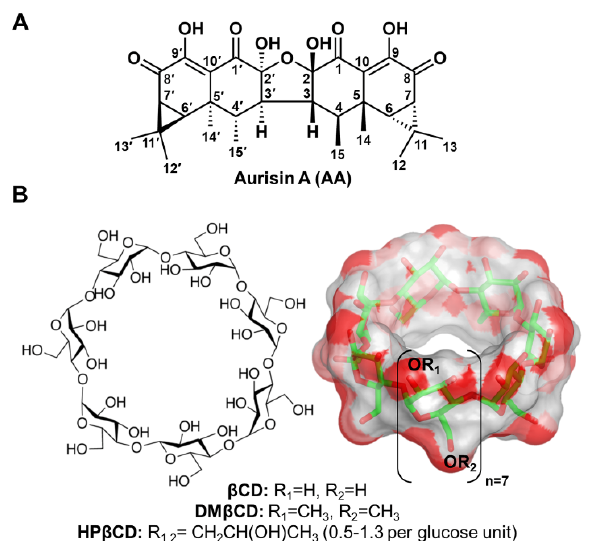
Figure 1. Chemical structures of ( A ) AA and ( B ) β CD and its derivatives (DM β CD and HP β CD), where the functional substitutions used in this study, are shown below.